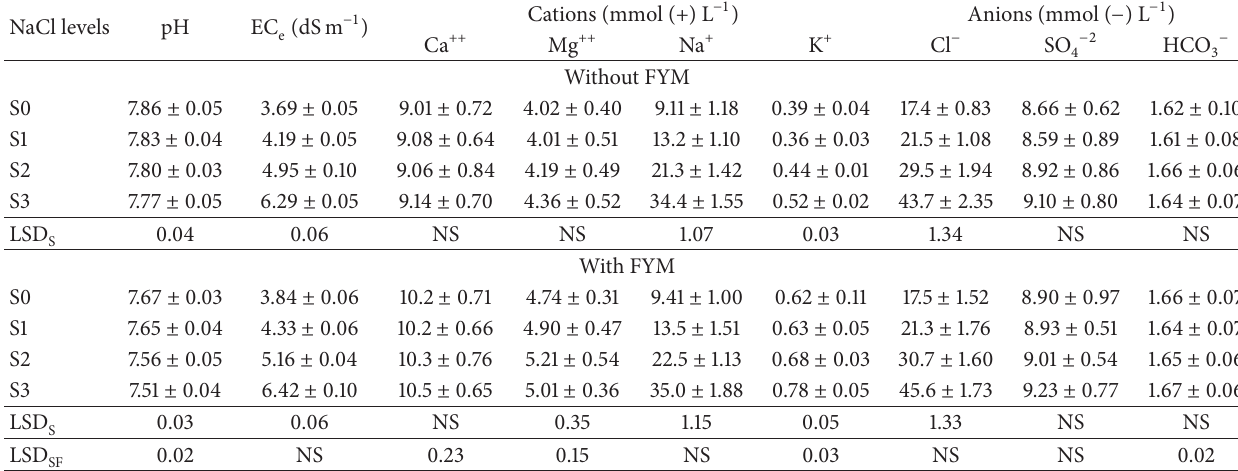
Table 1: Treatment effects on pH, EC